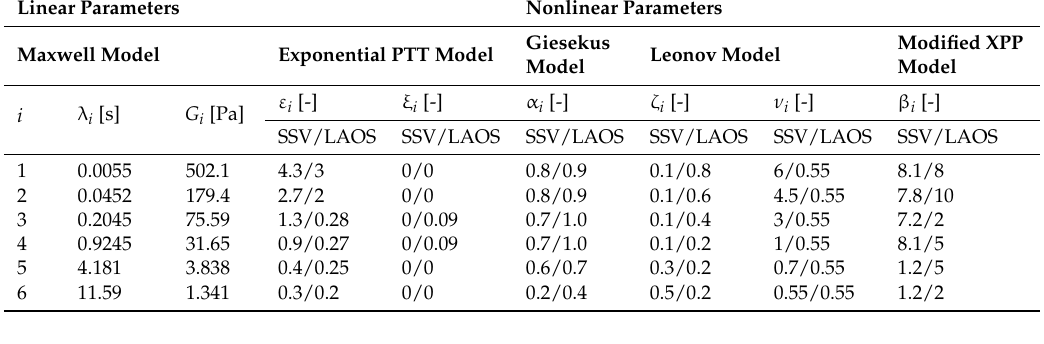
Table 2. Relaxation spectrum and the nonlinear parameters of the constitutive models based on optimization of steady shear viscosity (SSV) and on fitting LAOS data (LAOS).